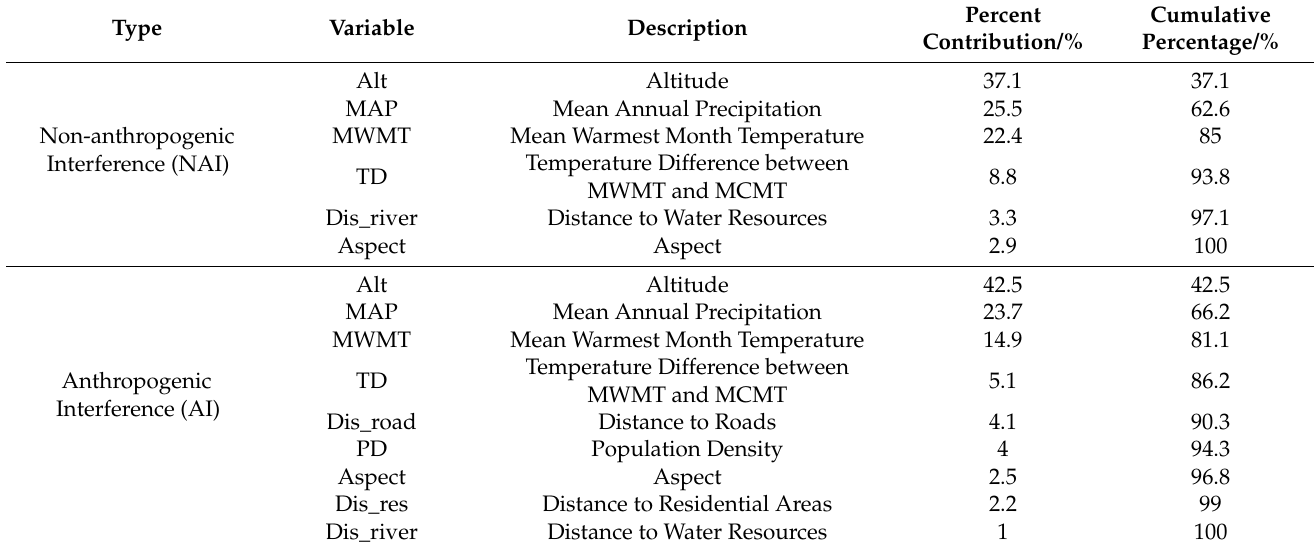
Table 2. Cumulative percentage contribution of environmental variables affecting Asian elephant distribution in Sipsongpanna under NAI and